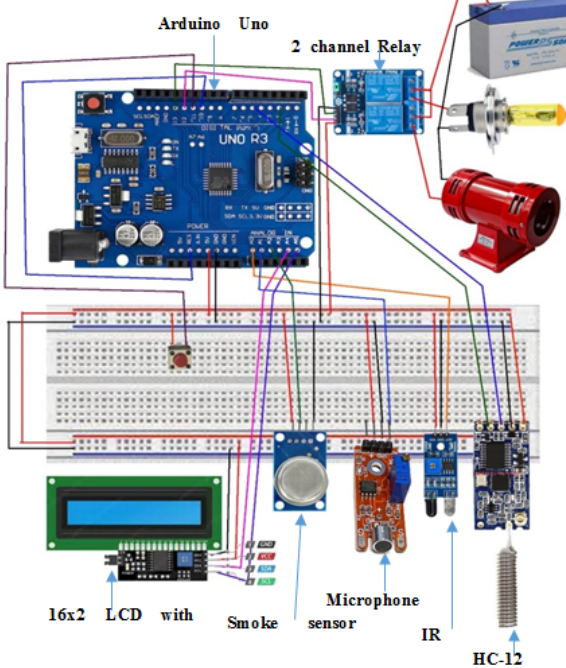
Figure 8. Wiring diagram for the AALS system node.